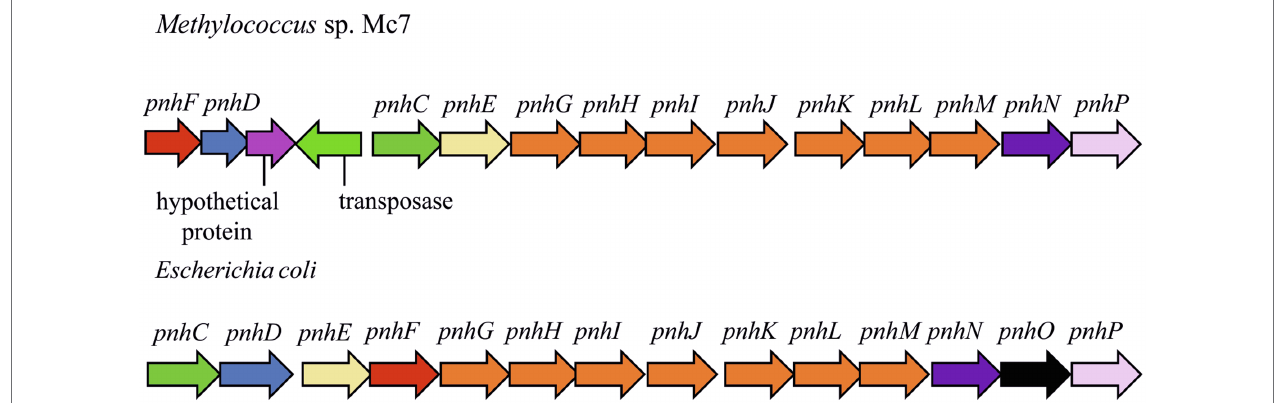
FIGURE 7 | The gene clusters carrying genes of pathway for organophosphonates degradation in methylotrophs and Escherichia coli . The products of the phn genes were proposed based on the comparison with the respective sequences in the Escherichia coli operon (Jochimsen et al., 2011): phosphonate ABC transporter ATP binding subunit ( phnC ); phosphonate ABC transporter periplasmic binding protein ( phnD ); phosphonate transport system permease protein ( phnE ); putative transcriptional regulator ( phnF ); carbon-phosphorus lyase core complex subunits ( phnGHIJK ); methylphosphonate degradation complex subunit ( phnL ); RPnTP hydrolase ( phnM ); ribose-1,5-bisphosphate phosphokinase ( phnN ); aminoalkylphosphonate N-acetyltransferase (phnO); 5-phospho-alpha-D-ribosyl-1,2- cyclic phosphate phosphodiesterase ( phnP